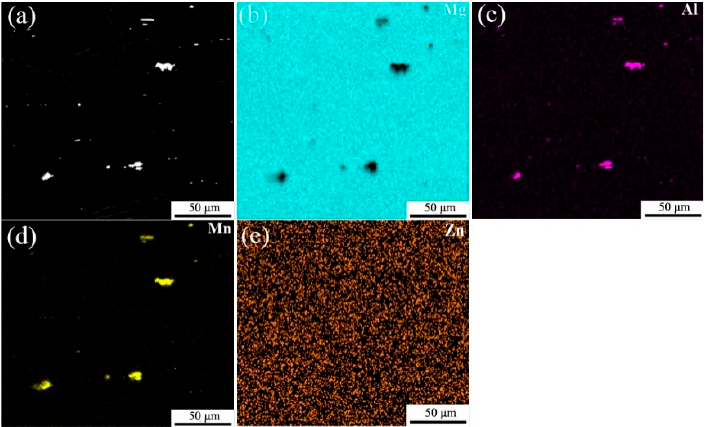
Figure 4. EDS mapping of the main alloying elements of as-extruded AZ31 in center area: ( a ) SEM image; ( b ) Distribution of Mg element; ( c ) Distribution of Al element; ( d ) Distribution of Mn element; ( e ) Distribution of Zn element.